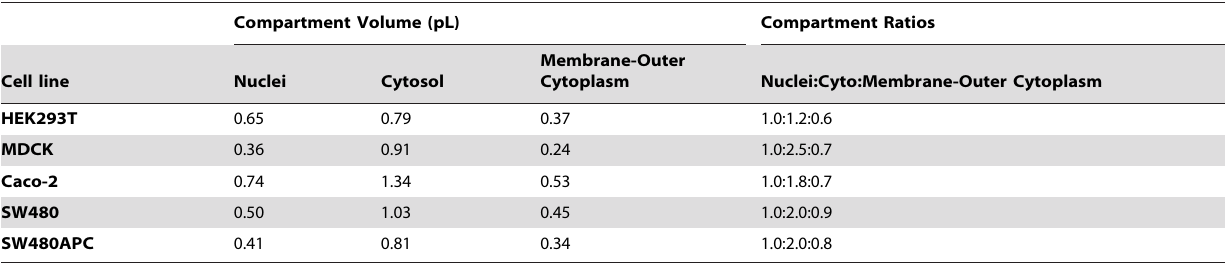
Compartment Volume (pL) Compartment